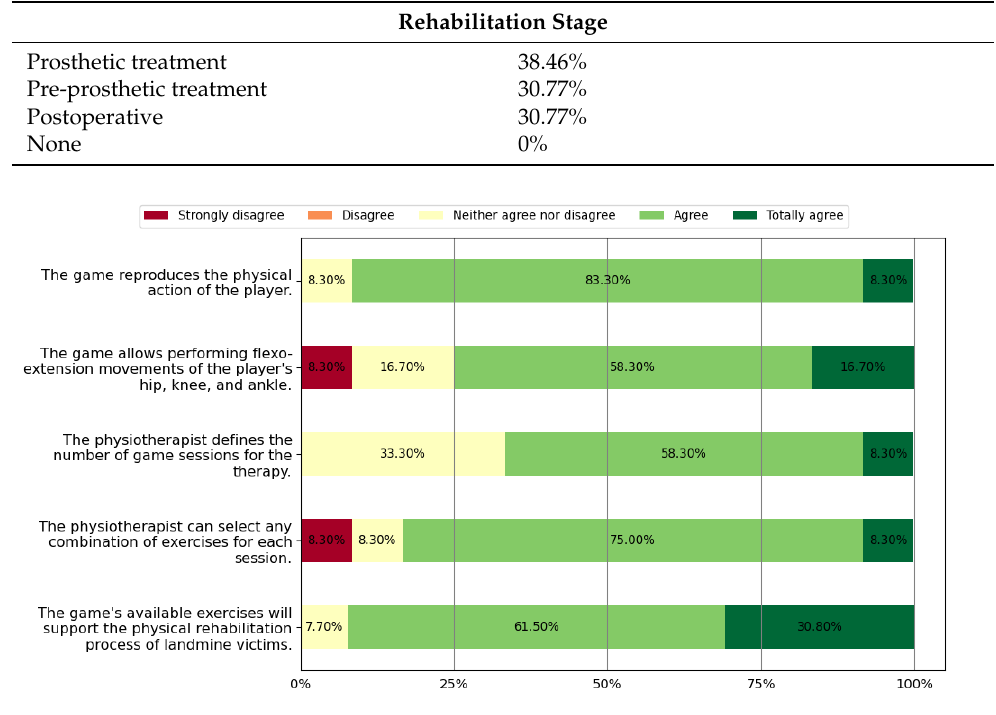
Table 8. Physical rehabilitation therapy stages for transtibial amputation in which physiotherapists consider that Kina could be useful.